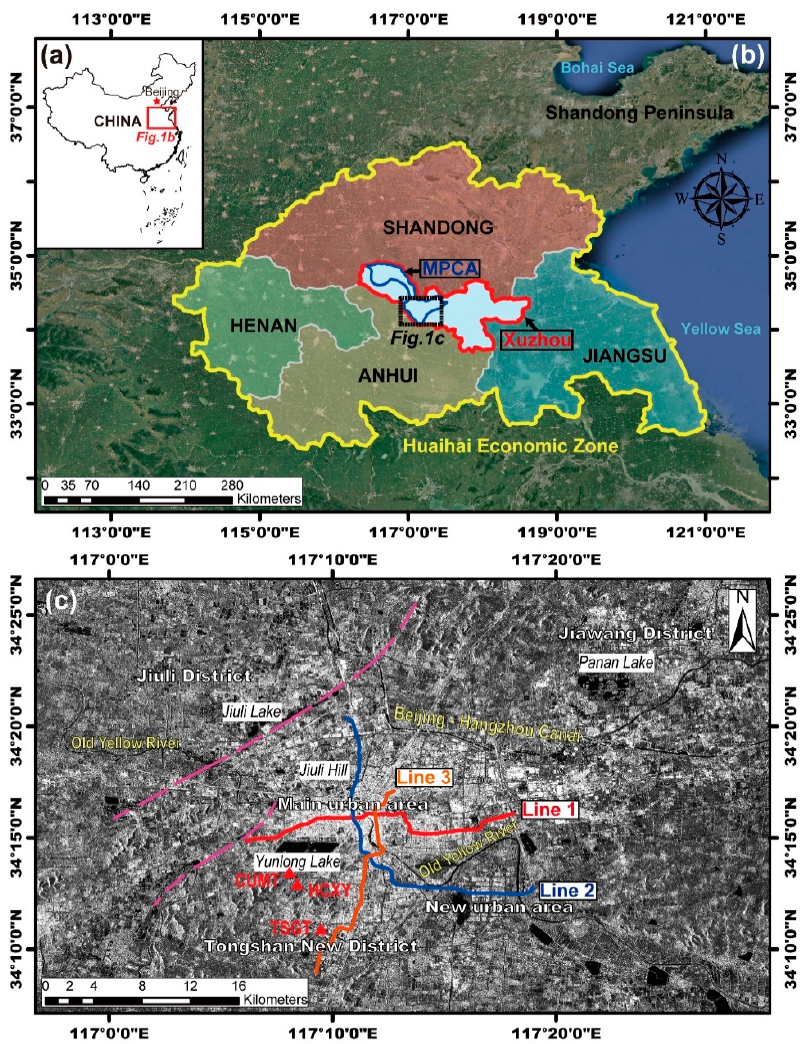
Figure 1. ( a ) Location of Huaihai Economic Zone in China. The red rectangle indicates the outline of ( b ). ( b ) Location of Xuzhou (outlined in red) in the Huaihai Economic Zone (outlined in yellow). The Xuzhou major geological disaster prevention and control Area (MPCA) is outlined in blue. The black rectangle represents the outline of ( c ). ( c ) Image of mean intensity of Sentinel-1A synthetic aperture radar data of the study area. Subway Lines 1–3 are indicated by red, blue and orange lines, respectively. Pink dashed lines indicate two synclines. Filled red triangles indicate the location of the Global Navigation Satellite Systems stations used in this study. Maps are projected in geographic Lat/Lon referenced to the WGS-84 datum.